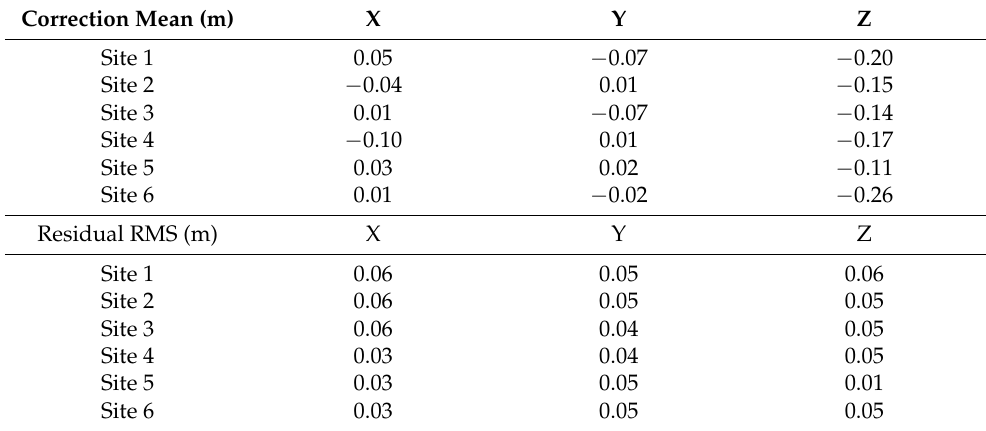
Table 3. Boresight calibration of high-density LiDAR data by using BayesStripAlign software (http:// bayesmap.com/products/bayesstripalign/ (accessed on 20 December 2021)). Mean global corrections and residual mean errors (RME) after correction are given.